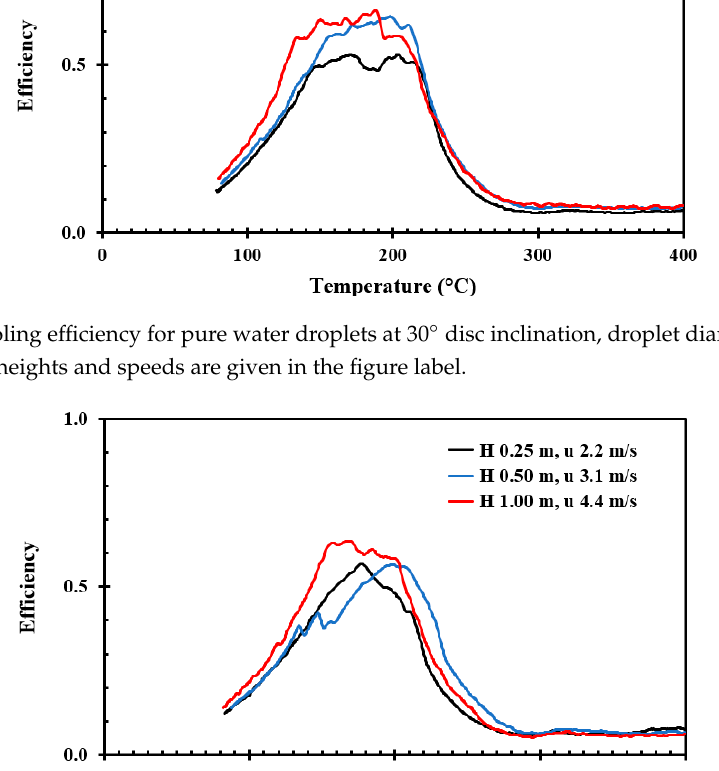
Figure 11. Cooling efficiency for pure water droplets at 60° disc inclination, droplet diameter 2.5 mm. Impingement heights and speeds are given in the figure label.